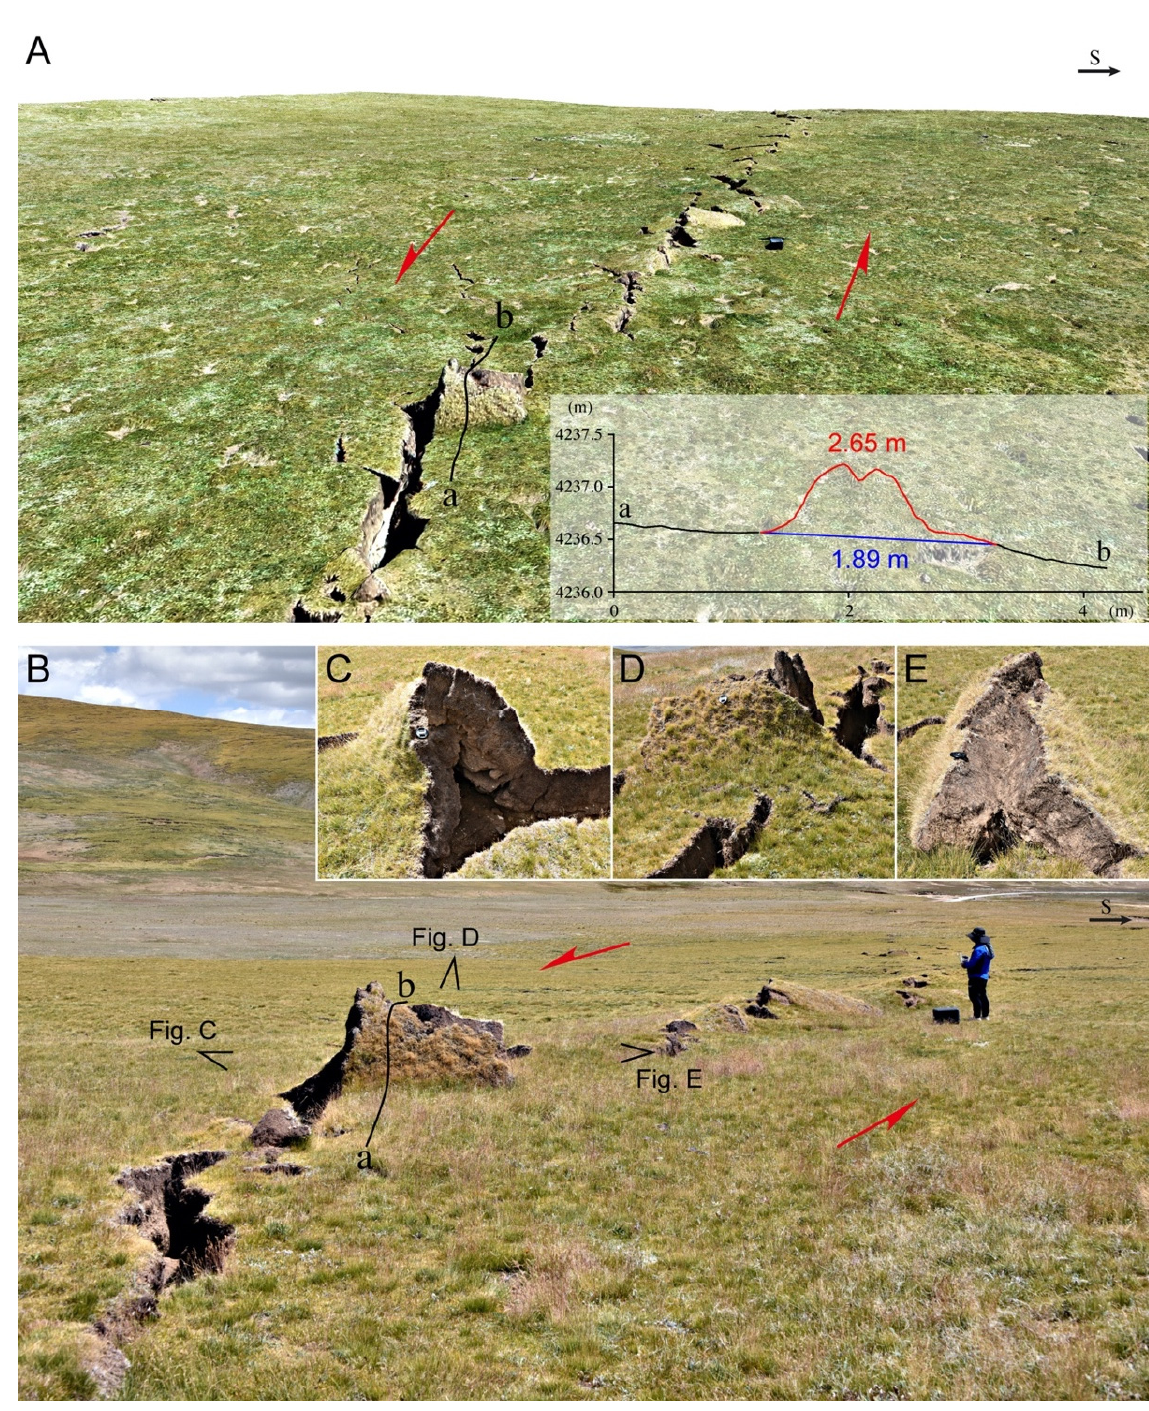
Figure 8. Push-up structures in the surface rupture. ( A ) 3D visualization image and measured profile of one push-up structure with a shortening of 0.76 m. θ is 30°, and the offset along the fault strike is 0.88 ± 0.2 m. ( B ) Field photo of the push-up. Panels ( C – E ) all represent different views on the uplifted feature shown in the middle of panel ( B ).